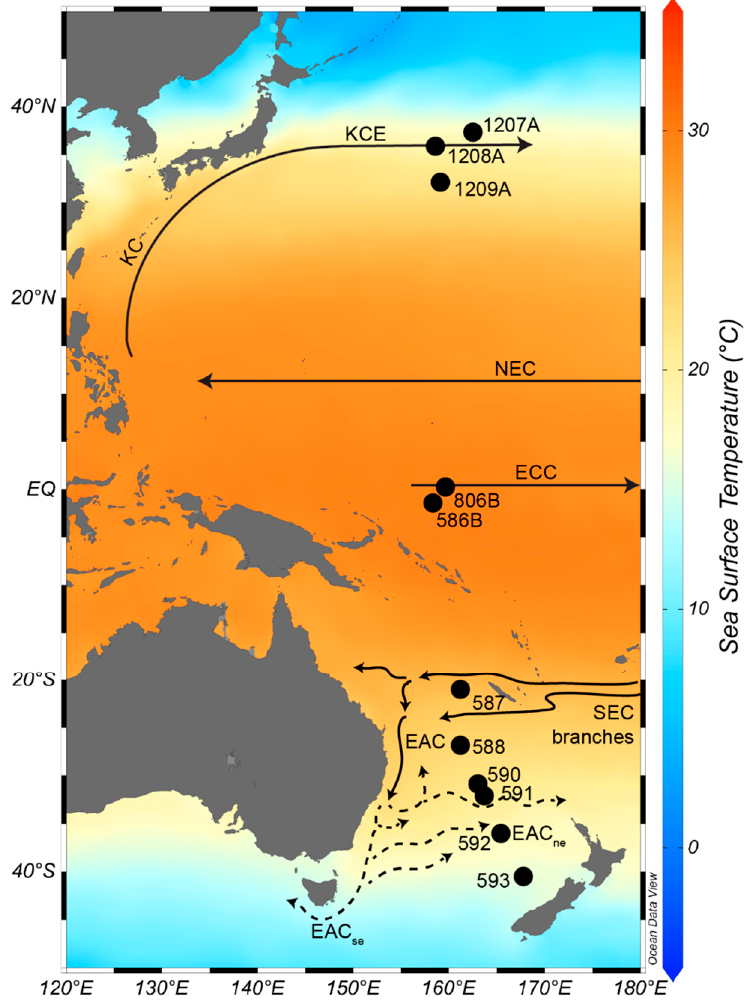
Figure 1. Modern-day sea surface temperature map of the western Pacific, with the 11 sites used in this study denoted by black circles. Major currents and eddy systems are denoted by solid and dashed lines, respectively. KCE, Kuroshio Current Extension; KC, Kuroshio Current; NEC, North Equatorial Current; ECC, Equatorial Counter Current; SEC branches, South Equatorial Current branches; EAC, East Australian Current; EAC ne , north extension of East Australian Current; EAC se , southern extension of East Australian Current. Map created using Ocean Data View [51] with sea surface temperature data from the World Ocean Atlas [52].